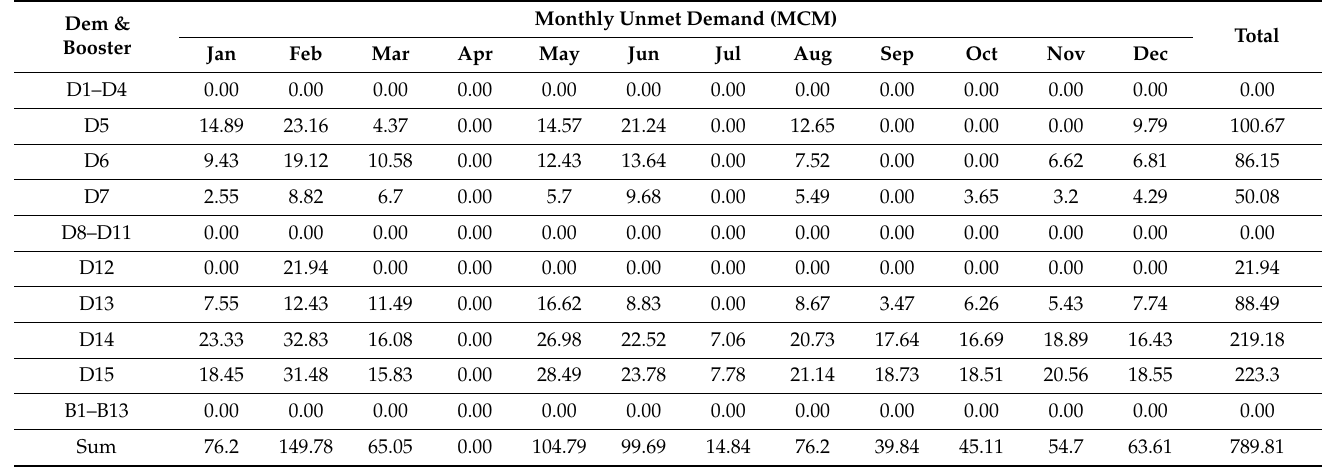
Table 7. Shortage water in case study (MCM).